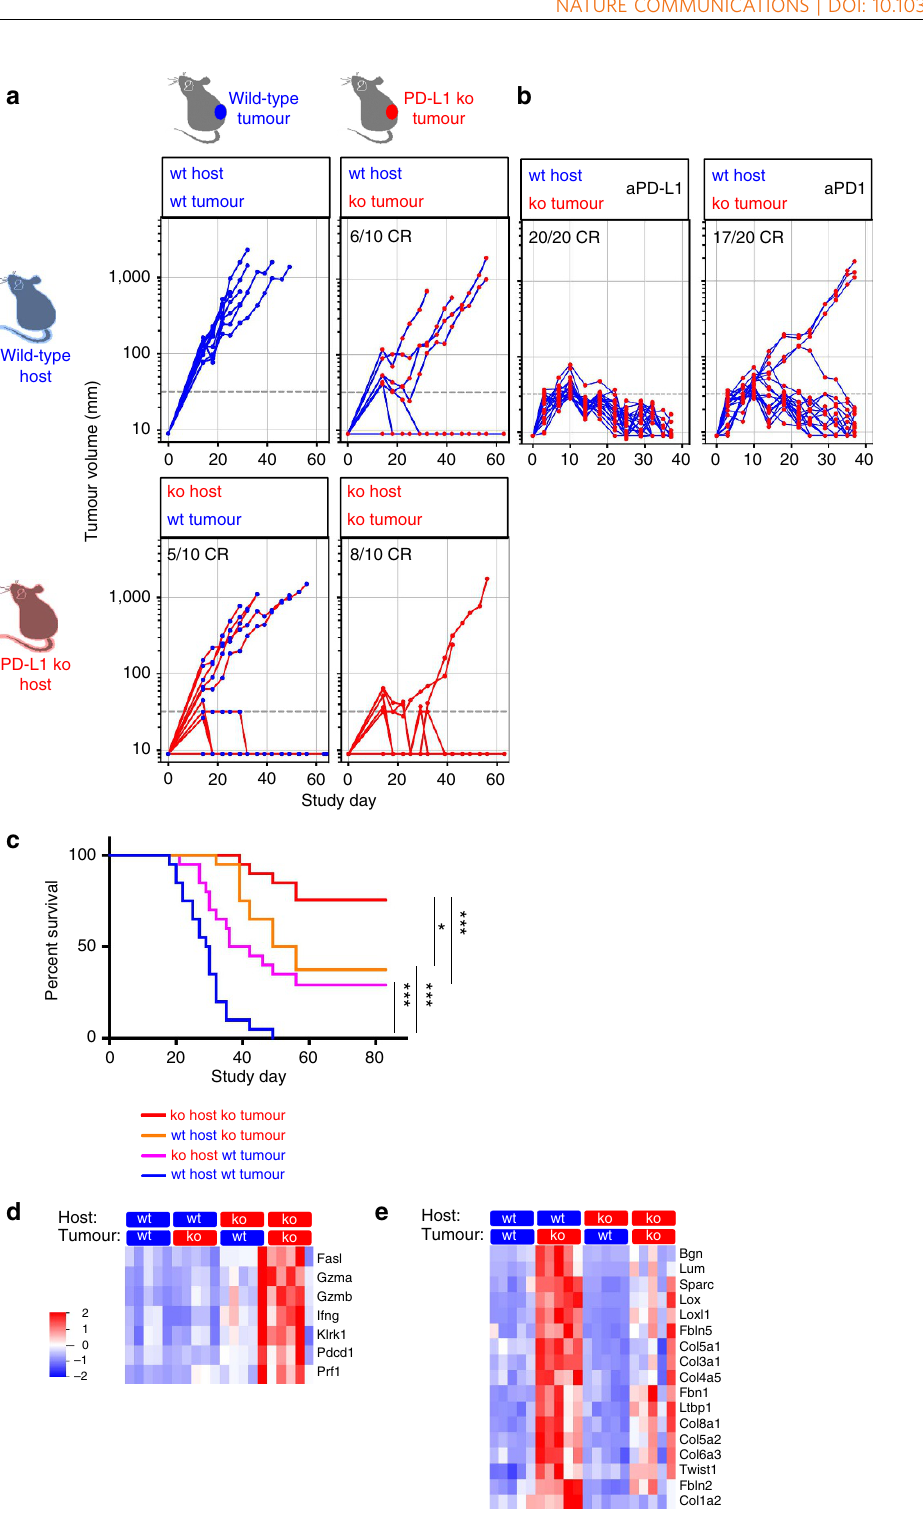
NATURE COMMUNICATIONS|8:14572|DOI: